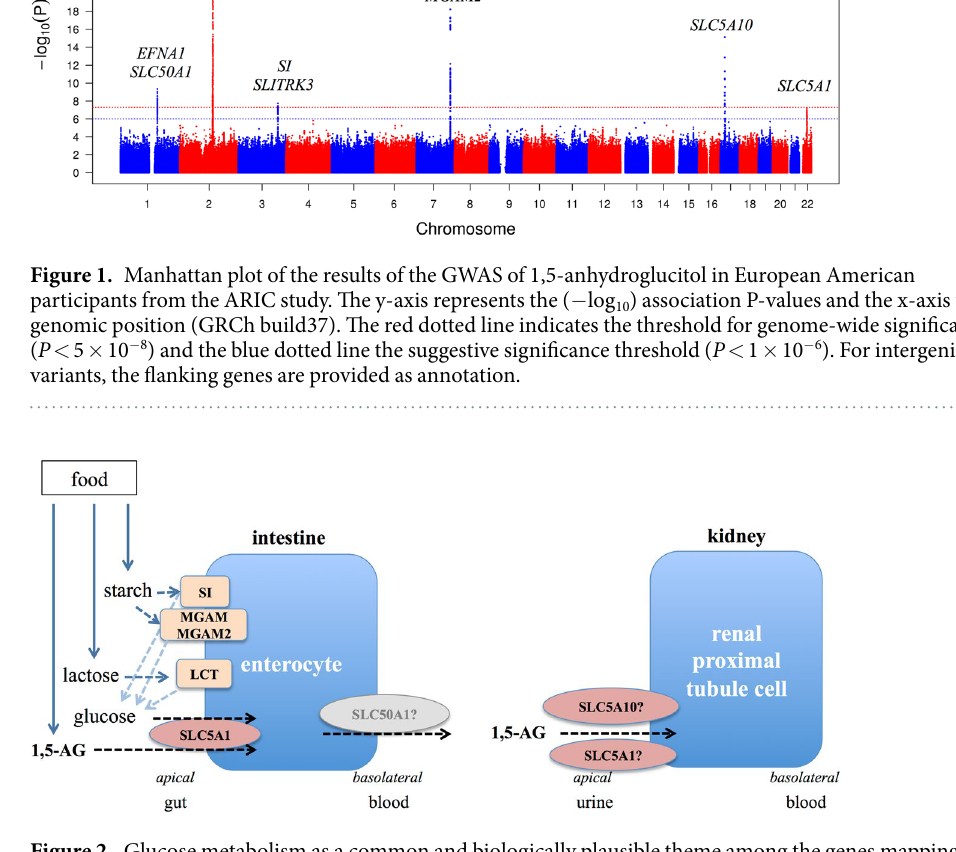
Figure 2. Glucose metabolism as a common and biologically plausible theme among the genes mapping into the identified loci. This figure shows their role in intestinal carbohydrate digestion as well as glucose and 1,5-AG reabsorption in gut and